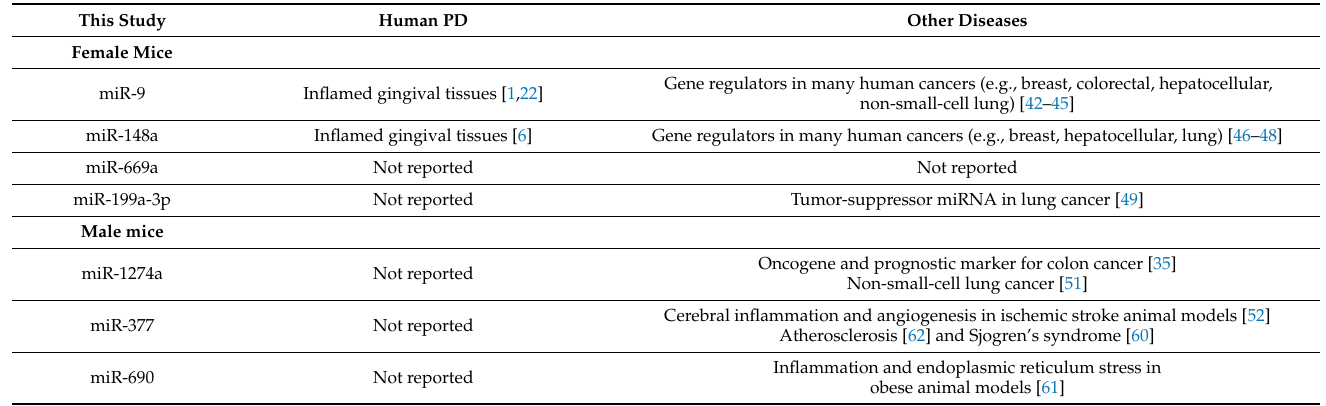
Table 4. Comparison of the presence of the dominant miRNAs in this study in human periodontitis and other